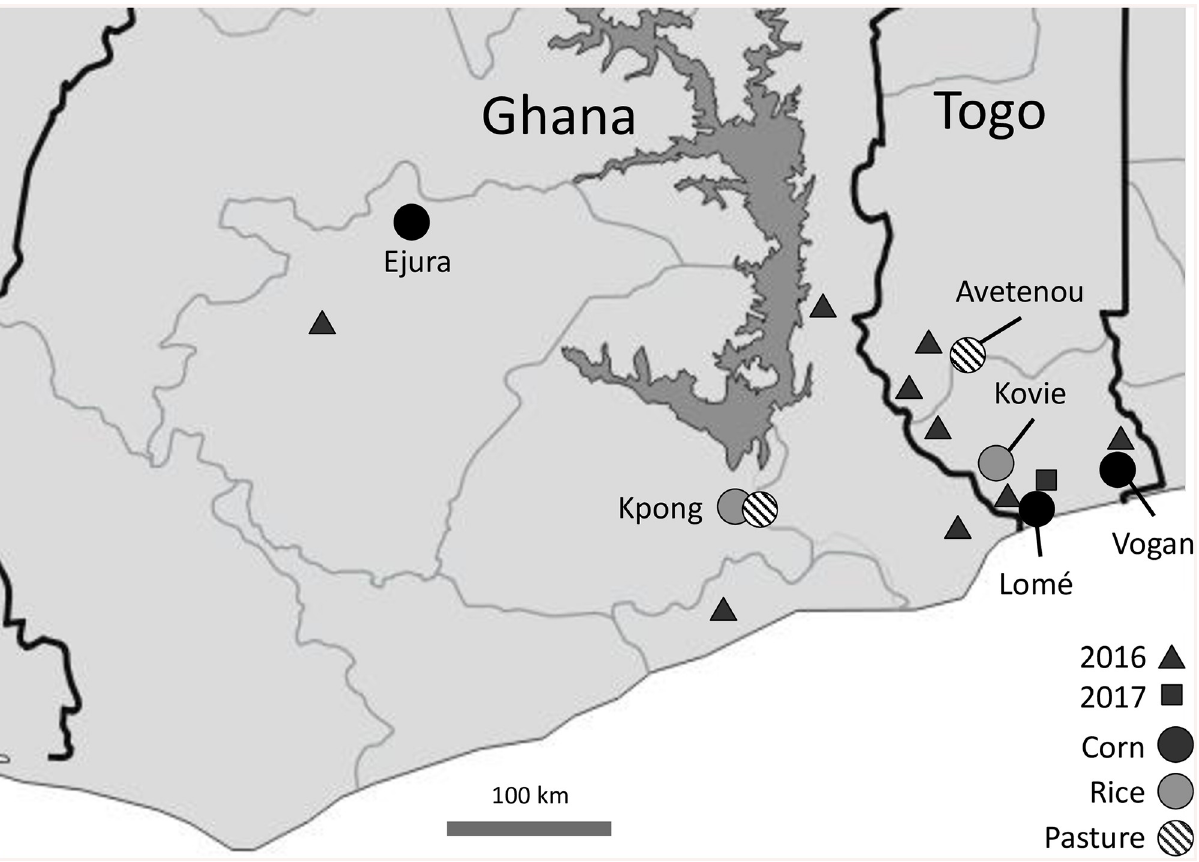
Fig 1. Map showing locations of fall armyworm collections in Ghana and Togo. Major towns near locations surveyed in 2018 are labeled. Sites are described in Table 1. The map was generated using QGIS version 2.18.2 (Open Source Geospatial Foundation).